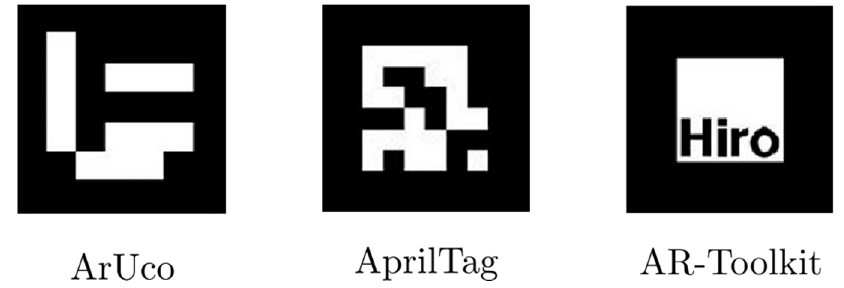
Figure 1. Examples of square fiducial markers.